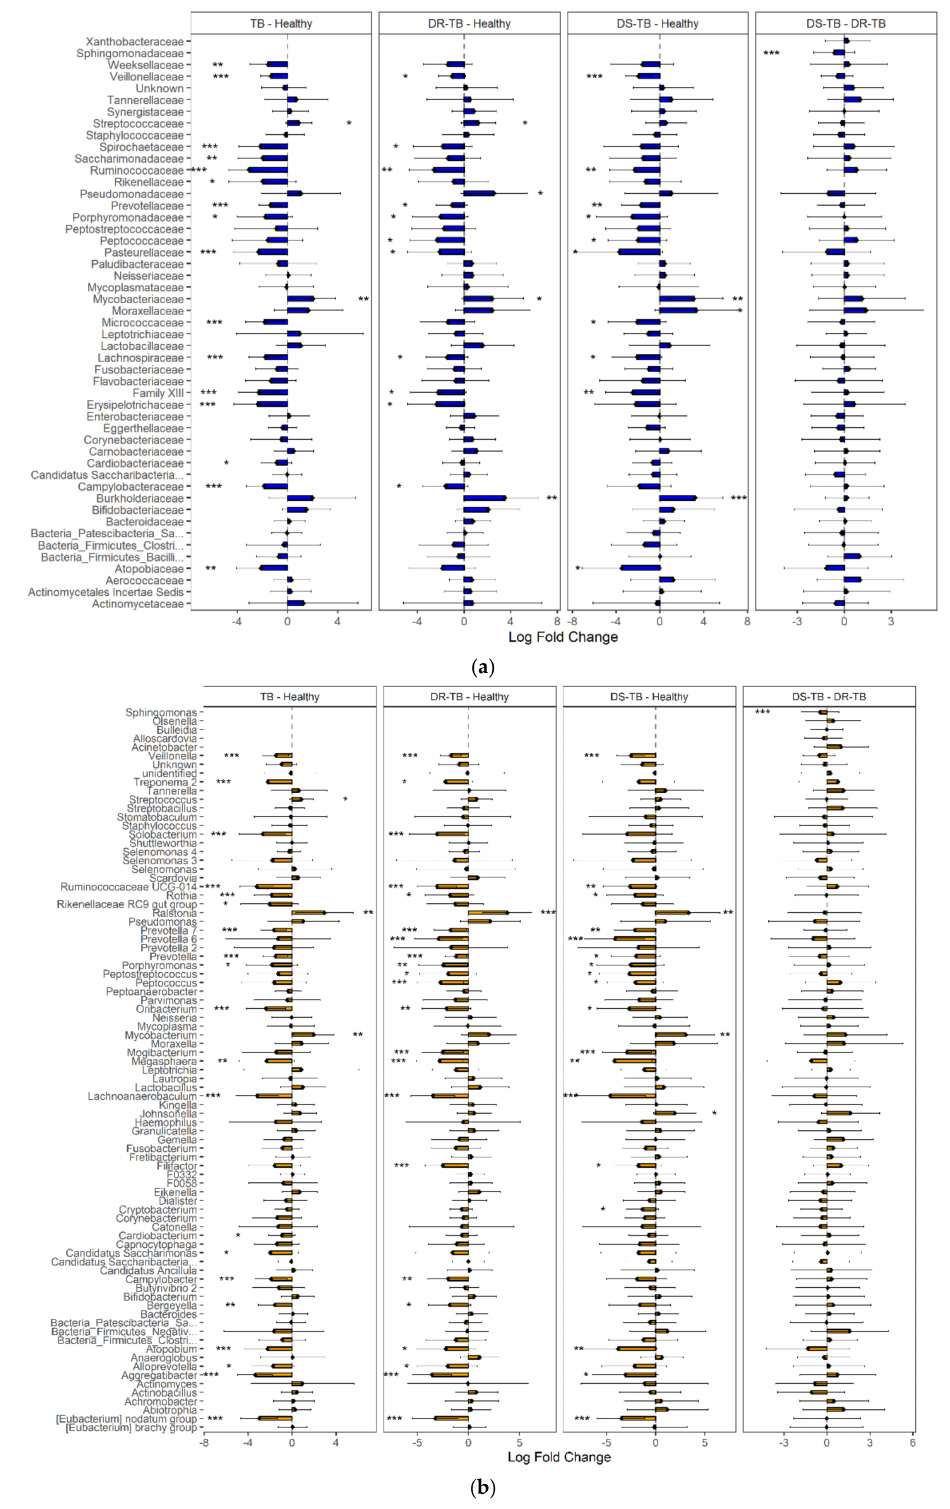
Figure 5. Differential abundance in sputum composition among HVs, DR-TB patients, and DS-TB patients. ANCOM-BC analysis showed differential abundance between TB vs. HV, DR-TB vs. HV, DS-TB vs. HV, and DR-TB vs. DS-TB at the family level ( a ) and the genus level ( b ). Statistical significance between groups is indicated by *, ** and ***, corresponding to p < 0.05, <0.01 and <0.001